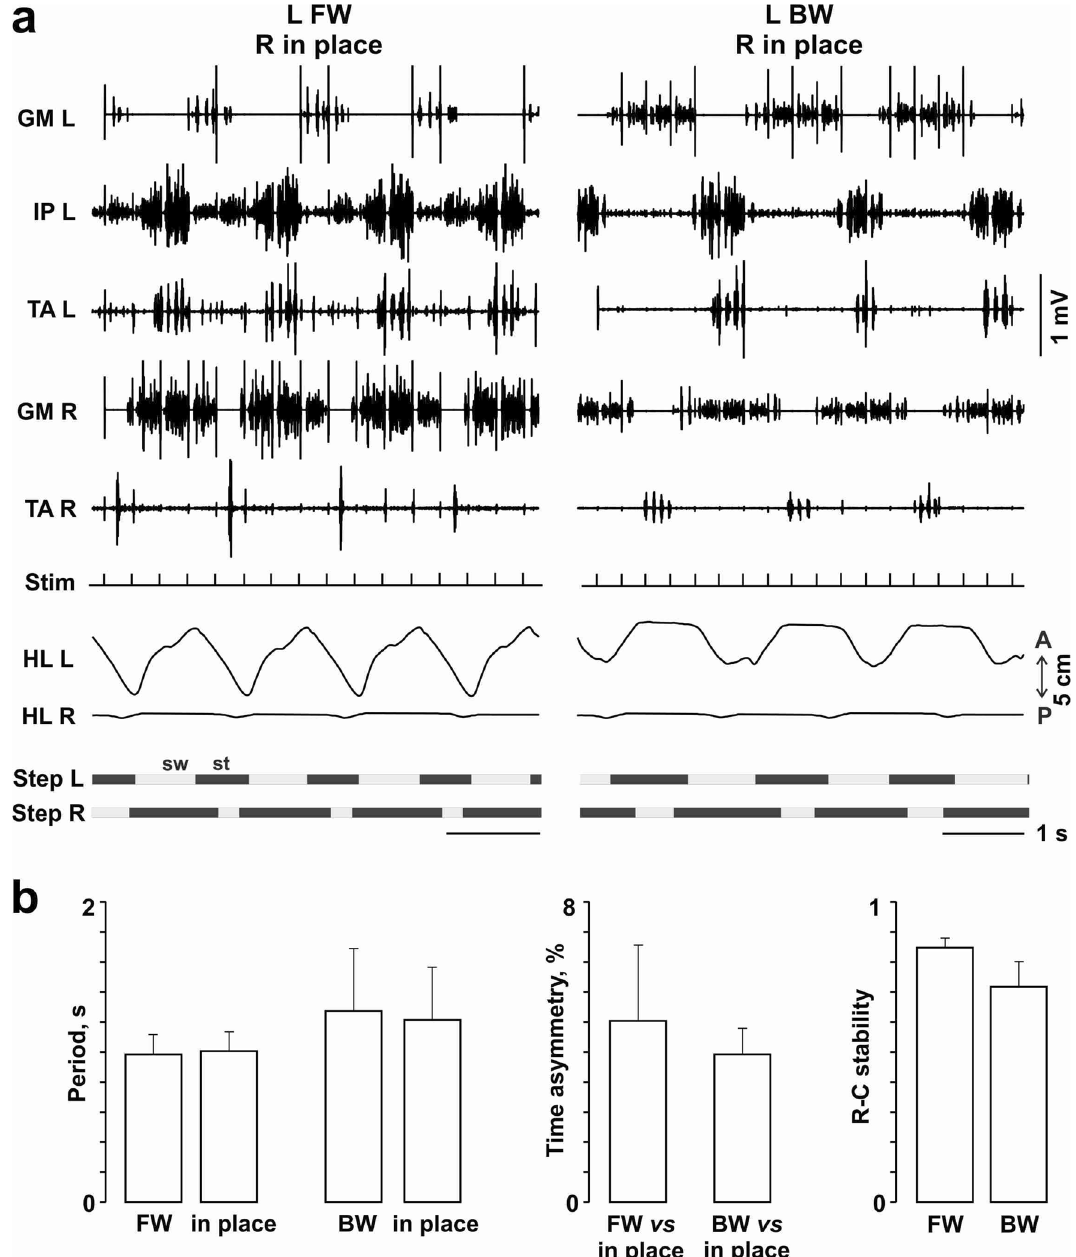
Figure 5. FW or BW of one leg while the other leg is stepping in place. ( a ) EMG pattern of left and right mm. iliopsoas (IP), tibialis anterior (TA) and gastrocnemius medialis (GM) during subsequent stepping of left and right hindlimbs (HL L, HL R). ( b ) The step cycle period and its asymmetry and the rostrocaudal During ES the specific somatosensory input can change the direction mode of CPGs independently for the left and right sides. On the contrary, both BW and BIDI locomotion are absent during MLR stimulation, although its stimulation evokes FW. This confirms that the reciprocal muscle activity during locomotion generated by CPG depends on the supraspinal drive as well as on the somatosensory input. Presumably, the regulation of the dura- tion of stance and swing phases is performed independently by FW_BIDI and BW_BIDI hindlimbs (Fig. 1m). At the same time, the commissural interconnections regulate the temporal shift between the cycles of the left and right CPGs. Due to such interconnections, the step periods for both hindlimbs are approximately equal in BIDI locomotion (Fig. 1l) which gives evidence of strong commissural communication in both unidirectional and bidirectional locomotion. A similar finding was obtained for the split-belt paradigm for FW; for some intervals of split-belt speeds the speeds of both legs of infants 13 or both hindlimbs of spinal cats 12 moving on fast and slow belts were equal and intermediate between the belt speeds.